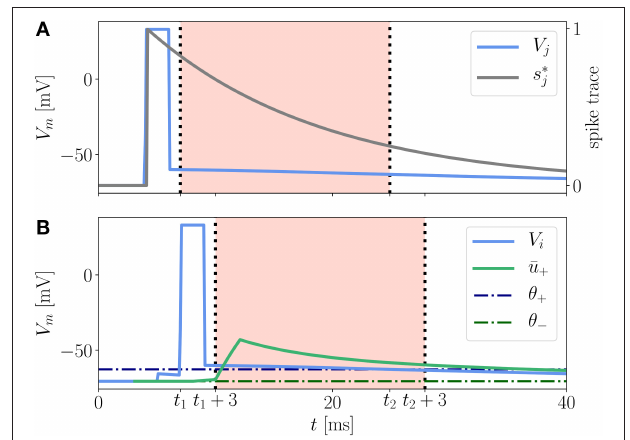
FIGURE 3 | Illustration of LTP contribution to the Clopath rule. A presynaptic neuron (A) and a postsynaptic neuron (B) emit a spike at t sp,pre = 4ms and t sp,post = 6ms, respectively. The presynaptic spike elicits a trace s ∗ j (gray) at the synapse. The excursion of the postsynaptic membrane potential V i ( B , blue) elevates the low-pass filtered potential ¯ u + (green) so that both V i and ¯ u + exceed the respective thresholds θ + (dash-dotted, dark blue) and θ − (dash-dotted, dark green), cf. (13), between t 1 and t 2 . Only within this period, shifted by d s = 3ms, which is for times t 1 + 3ms < t < t 2 + 3ms ( B , red background), see section 3.2.3 for details, the LTP of the synaptic weight is non-vanishing because of the threshold-linear functions in equation (13). The shift by d s = 3ms does not apply to the spike trace ( A , red background). The rectangular shape of the spikes is achieved by a clamping of the membrane potential to V clamp = 33mV for a period of t clamp =